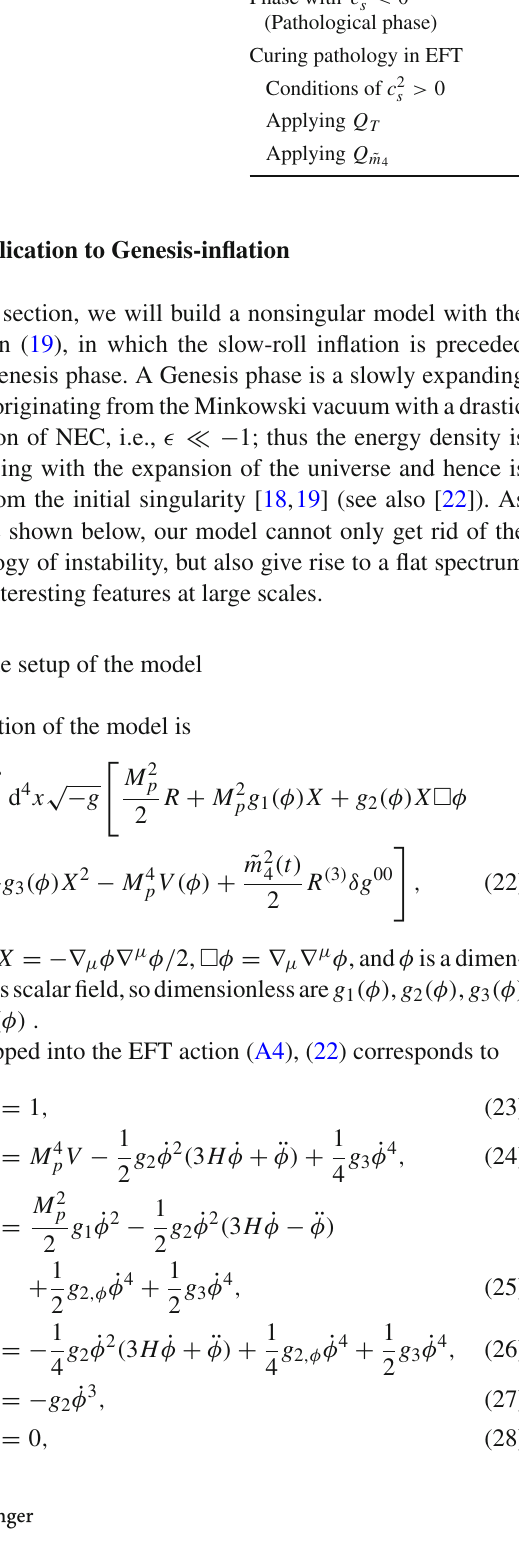
nonsingular cubic Galileon cosmological models and its cure in EFT by either Q T or Q ˜